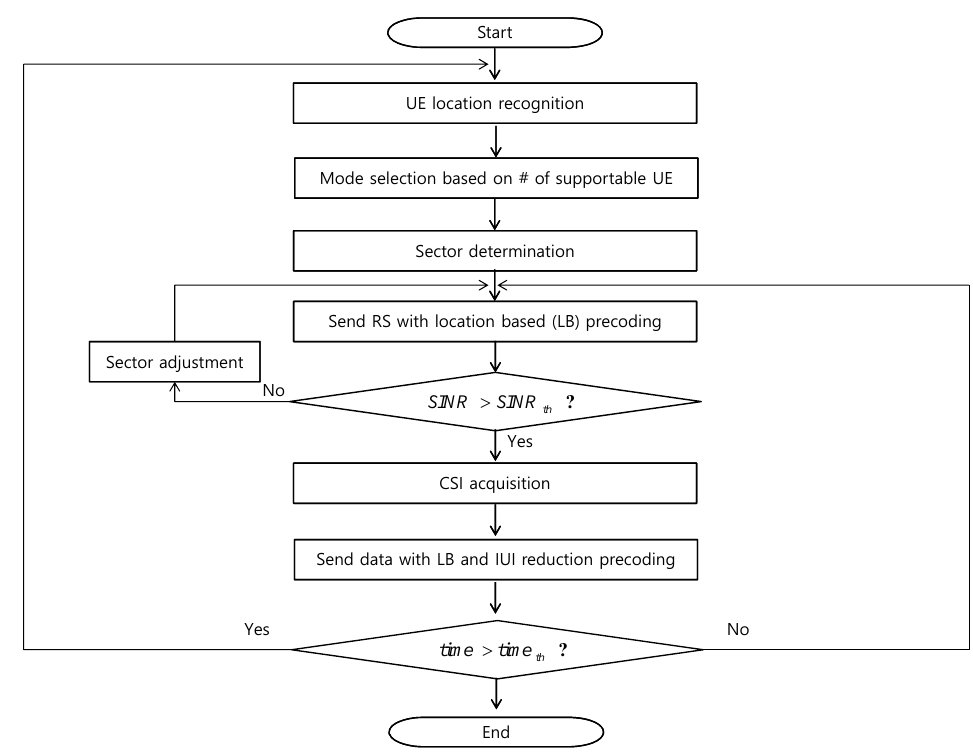
Figure 7. A modified BGRR algorithm to guarantee the space